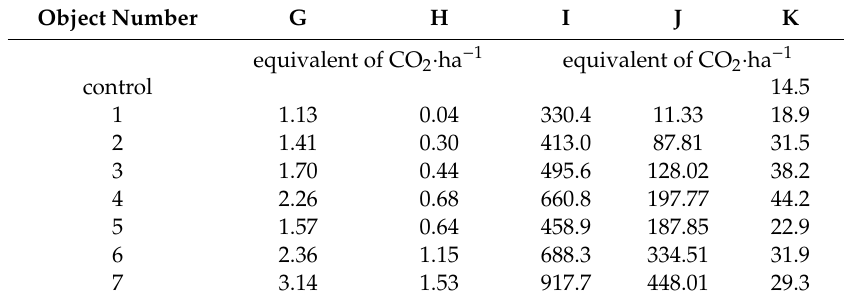
Table 5. Greenhouse gas (GHG)